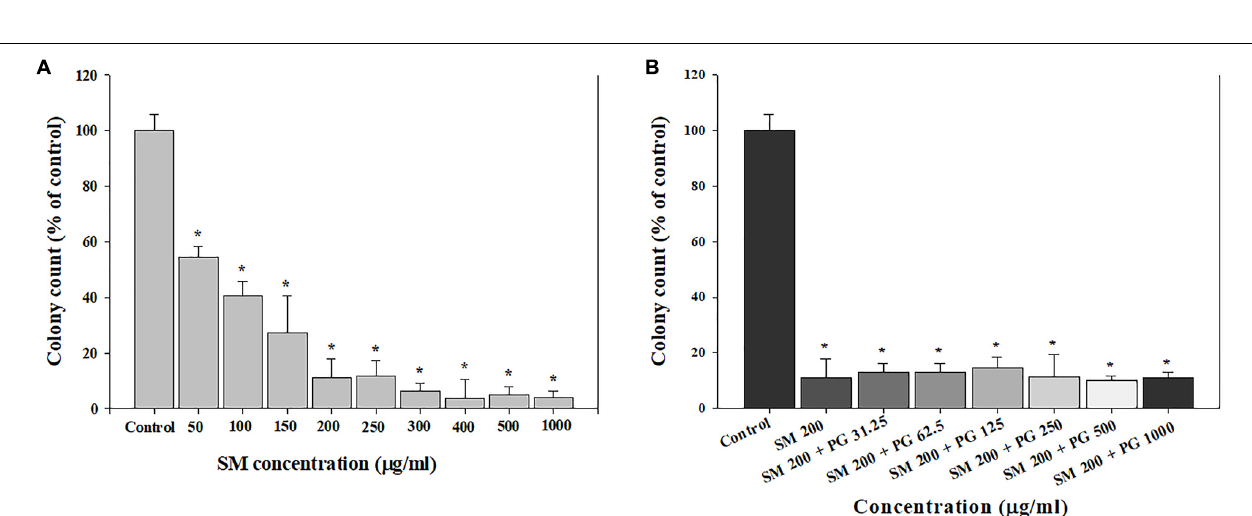
Frontiers in Pharmacology |